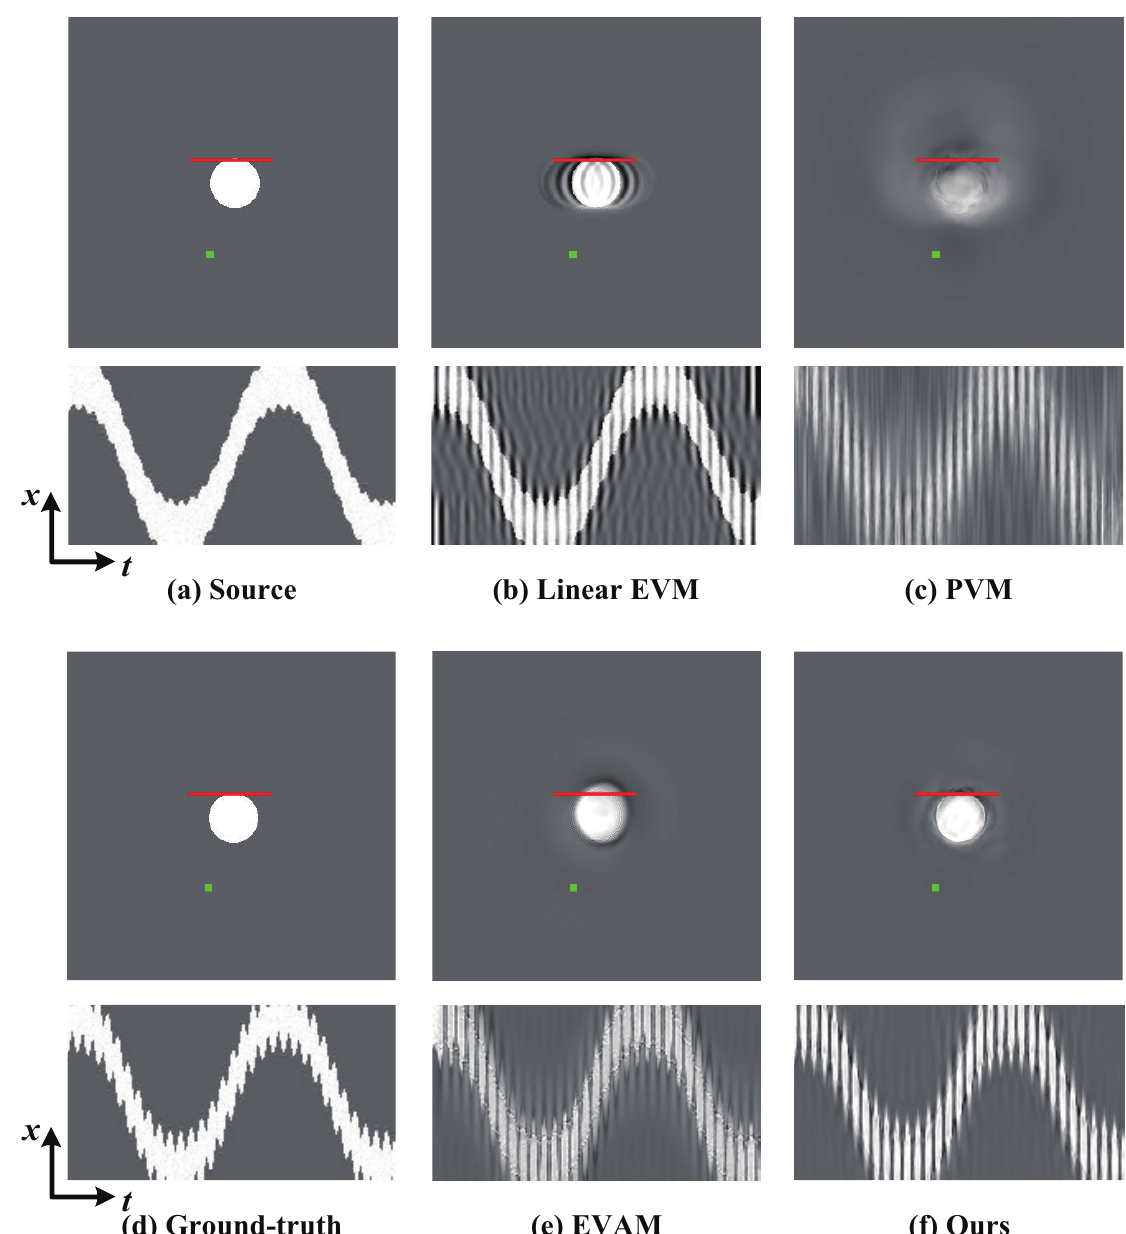
Figure 7. Ground-truth verification of our algorithm compared against different techniques on SynVideo2 in presence of nonlinear large motion. ( a ) Top: Original video frame. Bottom: A spatio-temporal Y − T slice of the video along the red line marked on the input frame. ( b,c ) Linear EVM [6] and phase-based motion magnification [12]. ( d ) The ground-truth. ( e , f ) Motion acceleration magnification [17] and our algorithm. Our algorithm reveals the small motion of interest and best resembles the ground truth, while other techniques generate significant blurring and